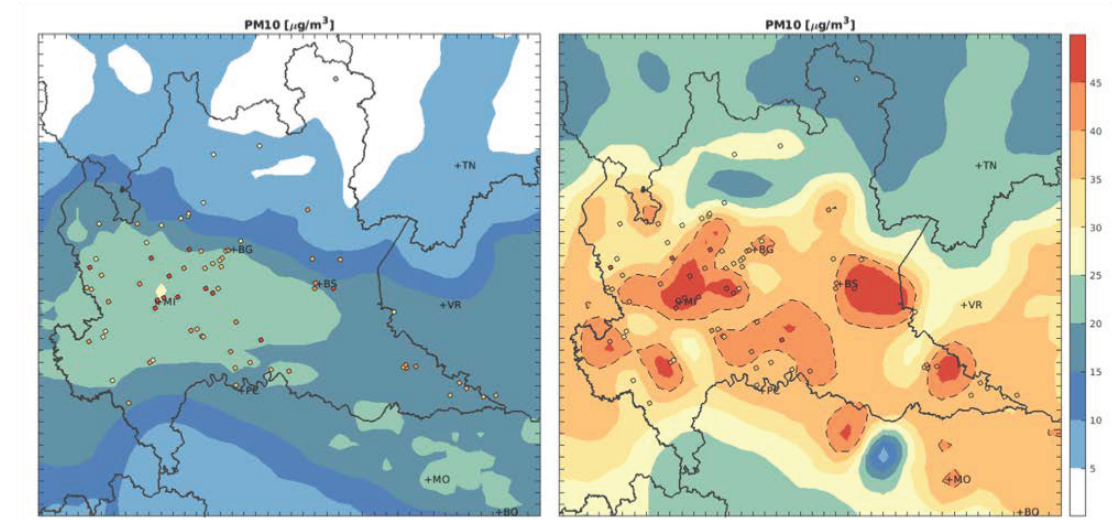
Figure 13. PM10 daily average concentration maps ( µ g/m 3 ) for CAMx and LS3 t + 1 forecasting. The dots represents the PM10 concentration values measured by the monitoring